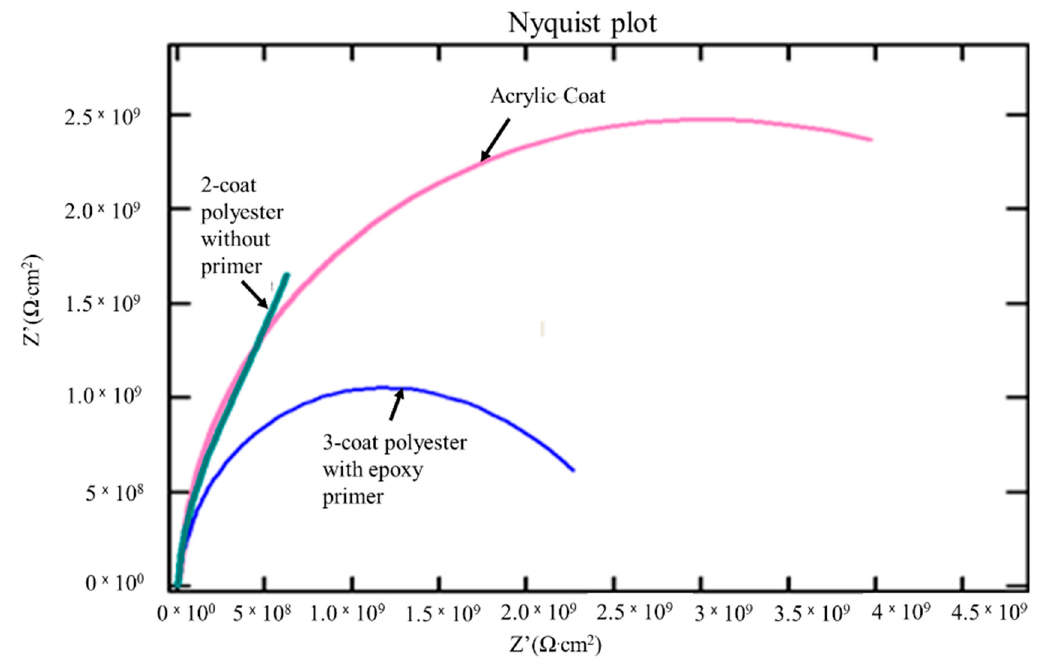
Figure 9. Nyquist plot.